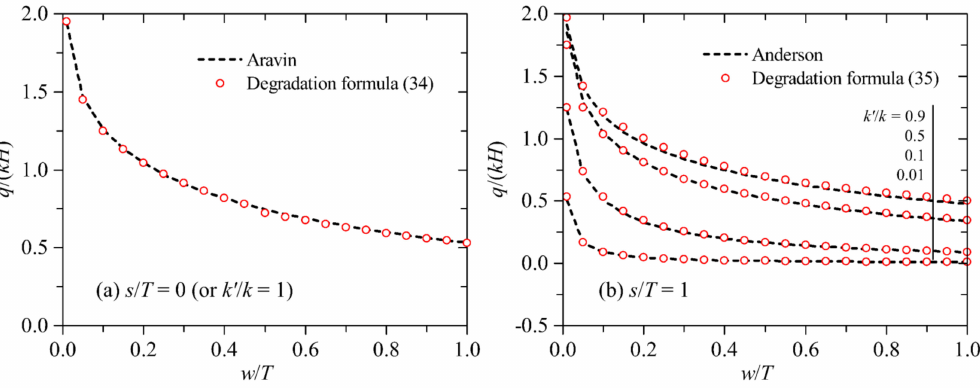
Figure 11. Flow calculation results of examples for ( a ) s / T = 0 (or k’ / k = 1) and ( b ) s / T = 1.